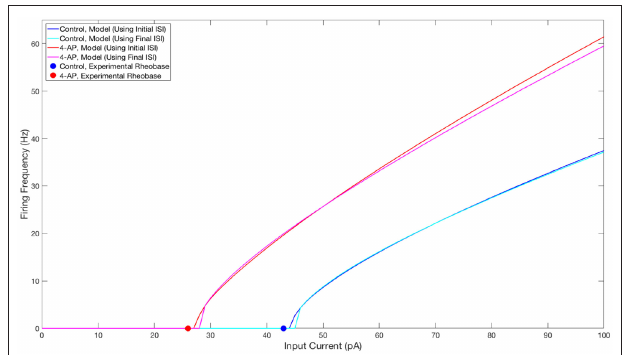
FIGURE 2 | FI curves illustrating properties of neuron models used in this study. FI Curves for control (blue and cyan) and 4-AP (red and magenta) modeled neurons. Curves are shown for frequencies calculated using the initial (blue and red) and final (cyan and magenta) inter-spike intervals to illustrate the tendency for spike-frequency adaptation (SFA). These comparisons show that the neuron models utilized in this study match the decreased rheobase and increased excitability and SFA of 4-AP treated neurons in comparison to control neurons (with the rheobases determined from unpublished in-house experiment for control and 4-AP neurons highlighted on the figure by the colored